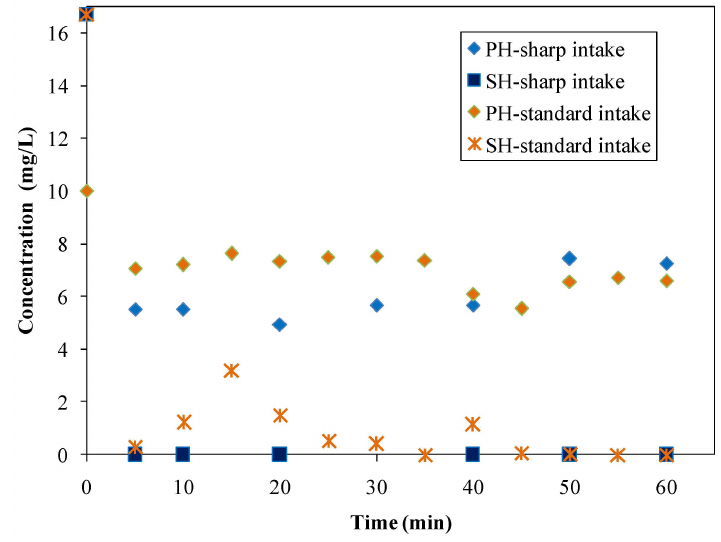
Figure 5. The concentration changes of model pollutants in the combined method, in the case of conventional and sharp adsorbent dosage, and during the monitoring of the pH (PH: phenol; SH: sodium